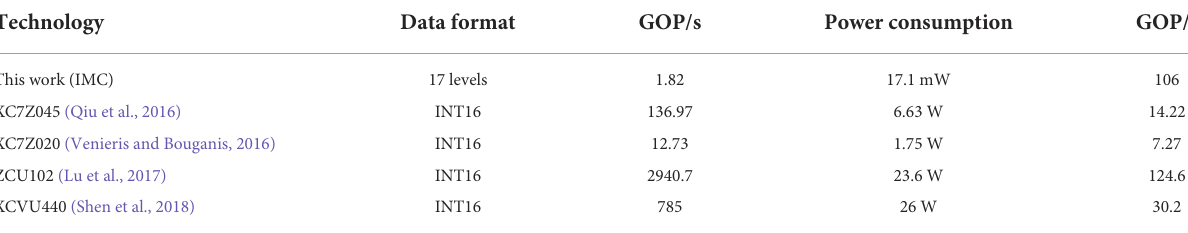
TABLE 2 Performance (GOP/s), power consumption (W), and energy efficiency (GOP/J) for different technologies candidated to accelerate the DeepSurv